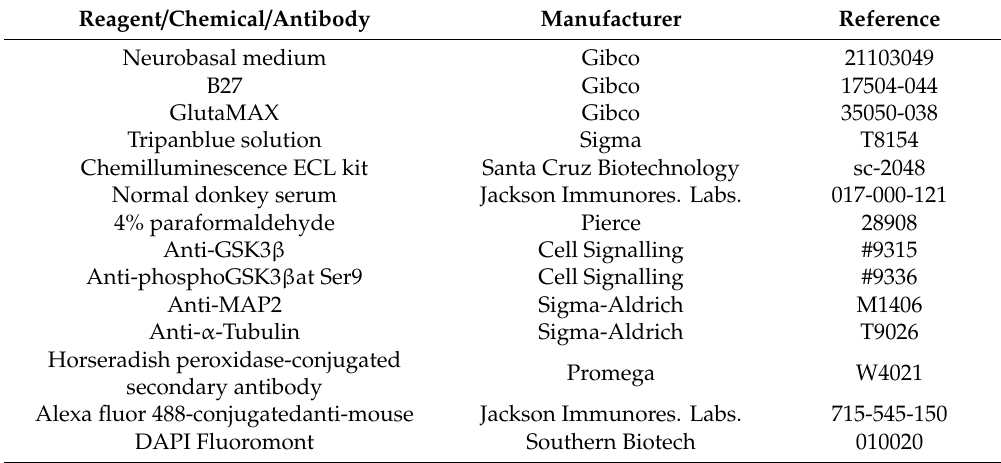
Table 1. List of essential chemicals, reagents and antibodies used in the present study. Reagent / Chemical /